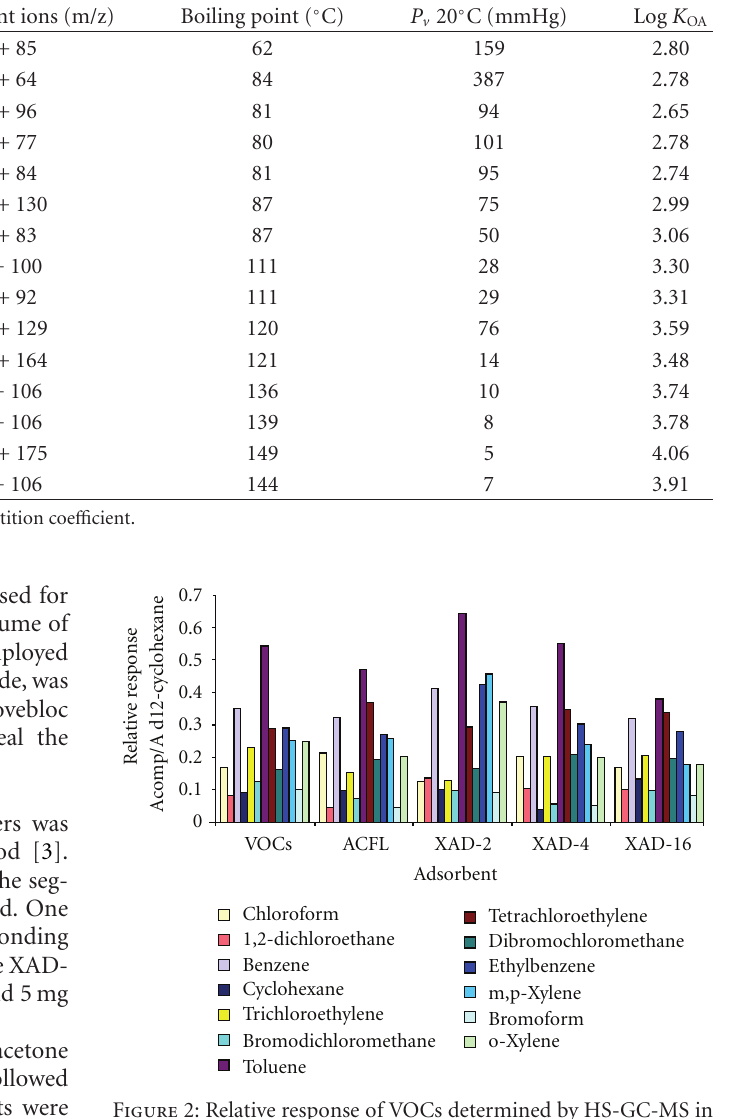
Table 2: GC-MS measurement parameters of the studied VOCs.